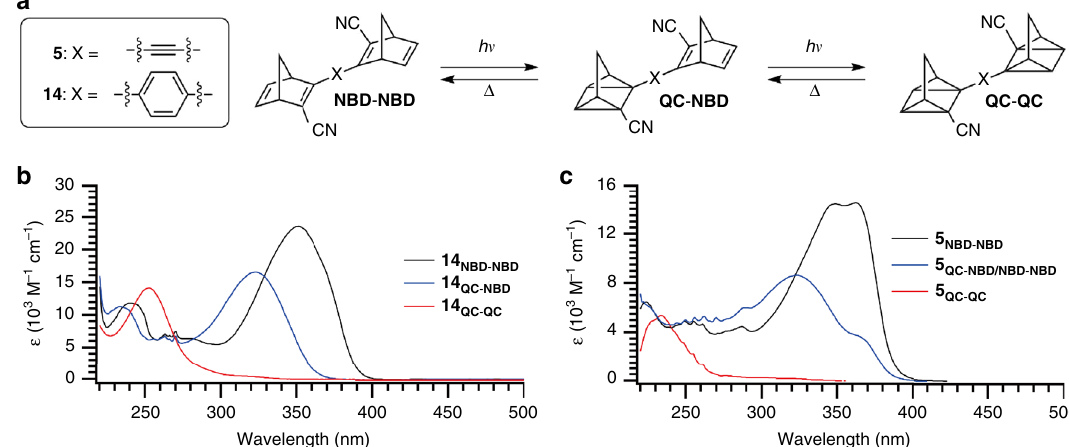
Fig. 6 Stepwise conversion of dimers. a Stepwise isomerization of 5 and 14 to the corresponding QC − NBD and QC − QC isomers. b UV − Vis spectra of 14 and its isomers. Black line: 14 NBD − NBD , blue line: 14 QC − NBD , red line: 14 QC − QC . c UV − Vis spectra of 5 , 5 QC − QC and the thermal-photostationary state between 5 and 5 QC − NBD . Black line: 5 NBD − NBD , blue line: the thermal-photostationary state between 5 and 5 QC − NBD , red line: 5 QC − QC